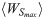
Heatmap showing top 50 ranked highly-conserved ortholog groups for representatives of each Alphaproteobacteria order.Each column designates a species, following the order dictated by a reference cladogram adapted from [44], placing Emcibacter congregatus and Rhizomicrobium palustre following their reported phylogeny in [45] and [46] respectively. Rows correspond to identified orthologous groups. For each cell, the cyan-yellow scale coloring indicates the posterior probability of regulation of the ortholog in that species (cyan blue—1, yellow—0). White cells indicate absence of the ortholog in that particular species. The left ancillary columns indicate, using the same color scale, the number of orthologs in each ortholog group (lowest value 11 out of 13) and the inter-species average of best extended GANTC instance score 〈WSmax〉, which has been used to rank the ortholog groups. Both values are shown normalized to the (0,1) range. The right ancillary columns indicate the two primary functional categories for the COGs assigned to each ortholog group, the description and identifier of which is shown adjacent. Highlighted descriptions denote ortholog groups also present in Fig 5.